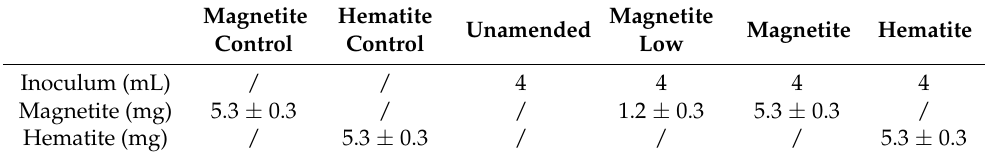
Table 1. Experimental setup of the microcosms. Magnetite Magnetite Hematite Magnetite Hematite Unamended Low Control Control Inoculum (mL) / / 4 4 4 4 Magnetite (mg) 5.3 ± 0.3 / / 1.2 ± 0.3 5.3 ± 0.3 / Hematite (mg) / 5.3 ± 0.3 / / / 5.3 ±